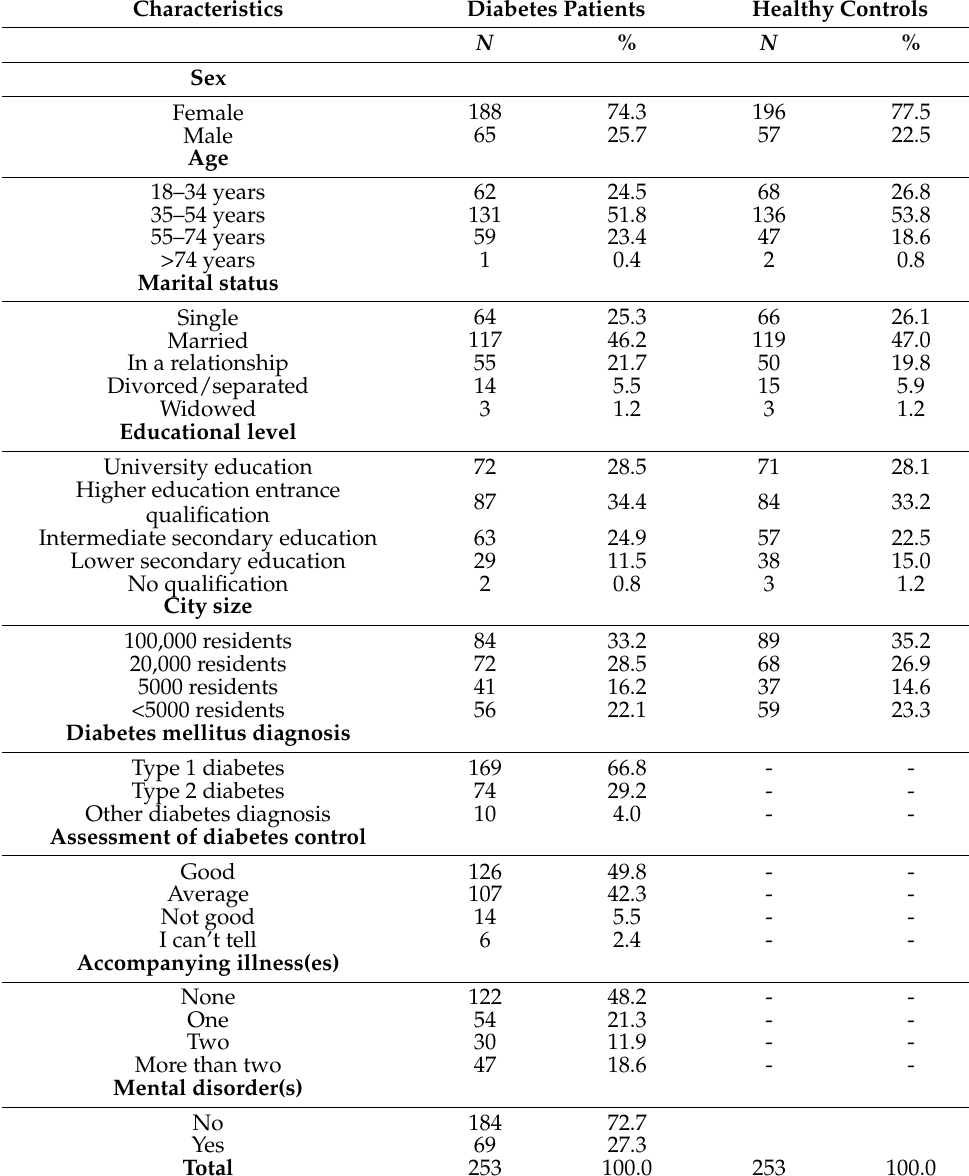
Table 1. Socio-demographic and medical